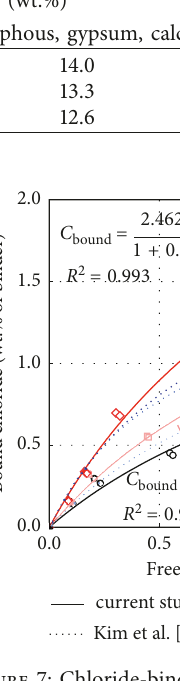
Figure 7: Chloride-binding capacity of PC, CD5, and